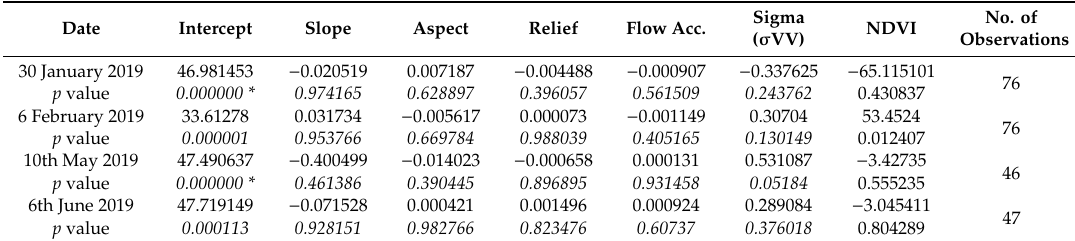
Table 4. Multiple Linear Regression